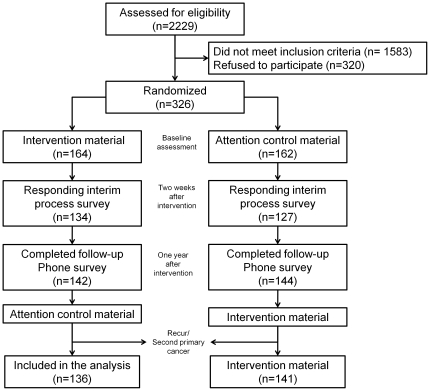
Flowchart of study participants.